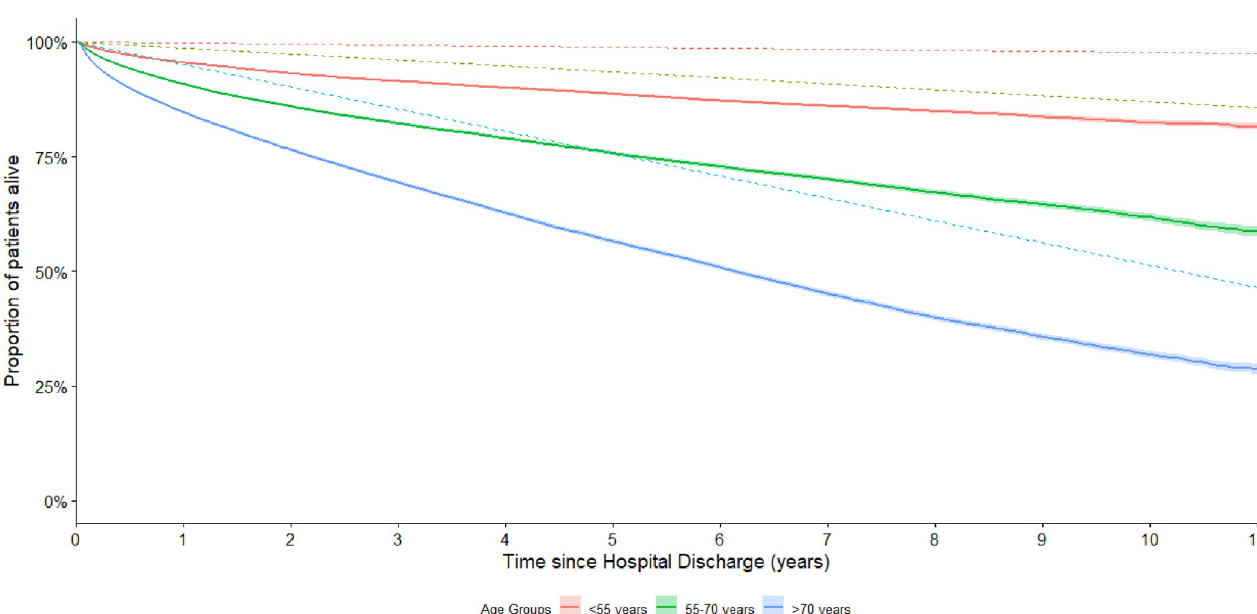
Fig 2. Survival curve of the study cohort stratified by age groups (solid lines) compared to the matched cohorts (dotted lines) (N = 130707). The 95% confidence intervals of the study cohort lines are represented by the shaded areas.